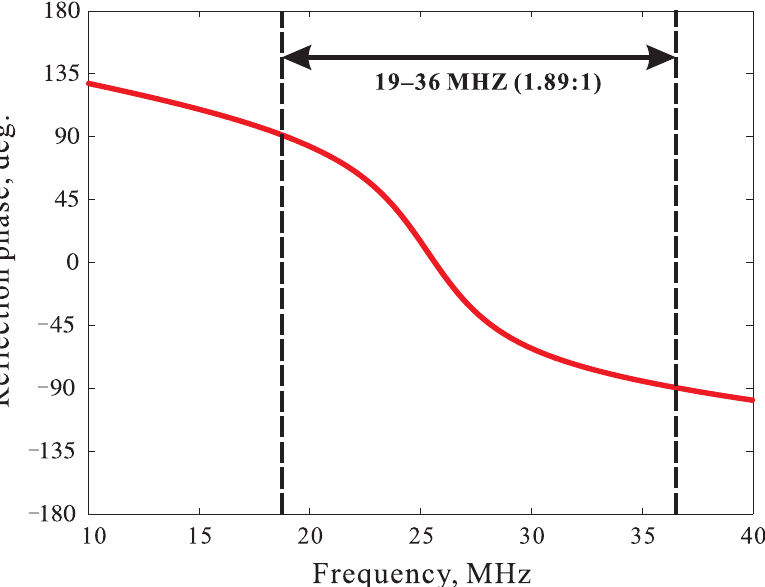
Figure 3. Simulated reflection phase of the proposed unit cell of the artificial magnetic conductor